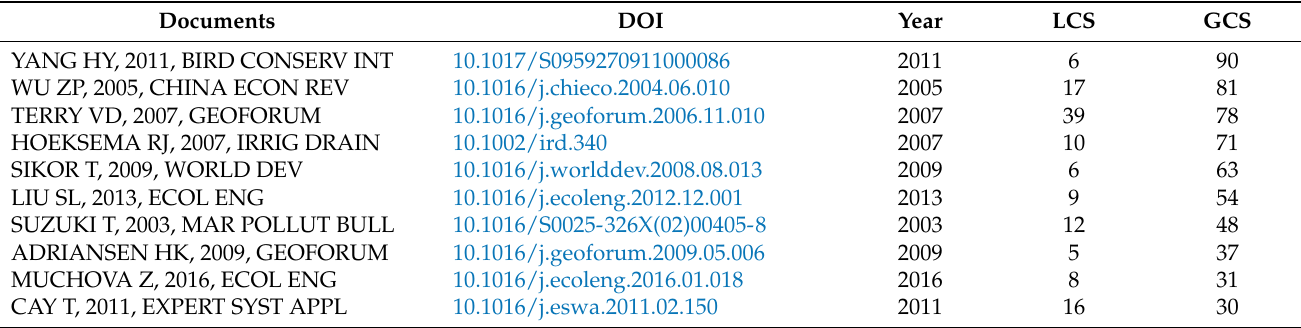
Table 2. Top 10 global citation scores (GCS) in land consolidation